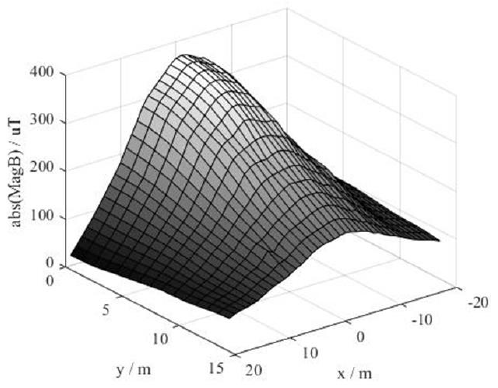
Figure 3. Magnetic field distribution of pole I smoothing reactor.